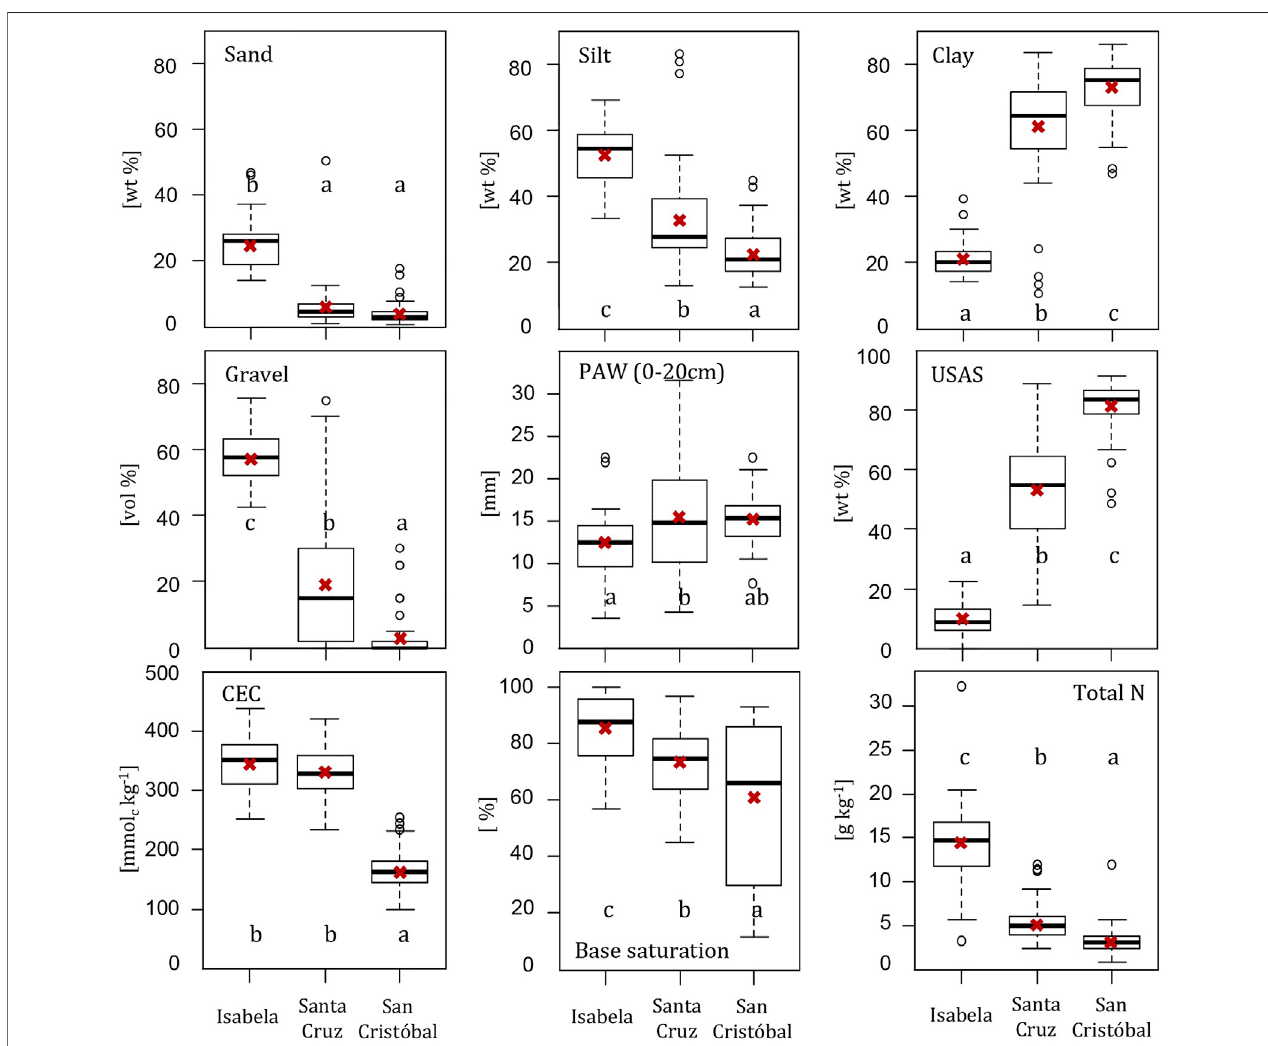
FIGURE 2 | Selected soil physical and chemical properties across the islands Isabela, Santa Cruz and San Cristóbal. Mean values are indicated by the symbol x, dots indicate outliers. Horizontal bars represent minimum, 25th percentile, median, 75th percentile and maximum. PAW (cid:1) plant-available water, USAS (cid:1) ultrasonic aggregate stability, CEC (cid:1) cation exchange